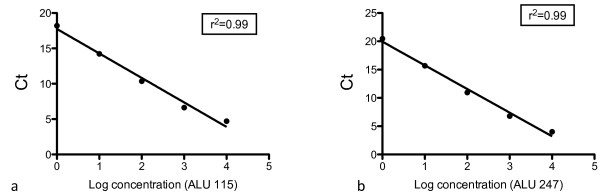
Standard curves of ALU 115bp and 247bp amplicons. DNA from female genomic DNA was serially diluted (from 10ng to 0.1ng) and used to construct the standard curves from which the quantity of DNA of the patients was calculated.